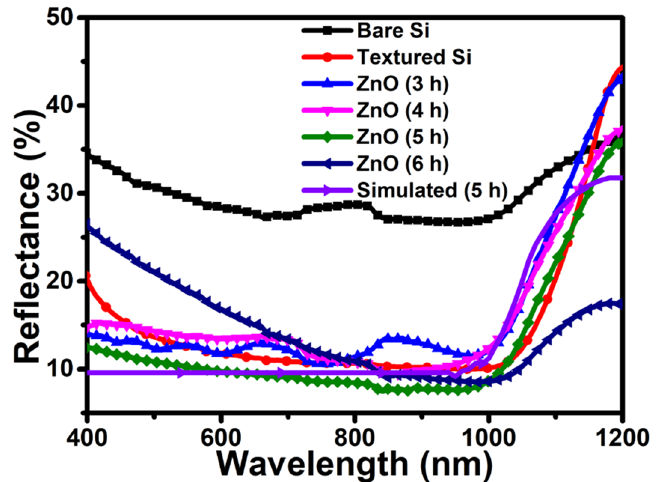
Figure 6. UV-Vis spectra in reflectance mode of the bare Si wafer, textured Si wafer, and vertically arranged ZnO NRs on textured Si wafers.